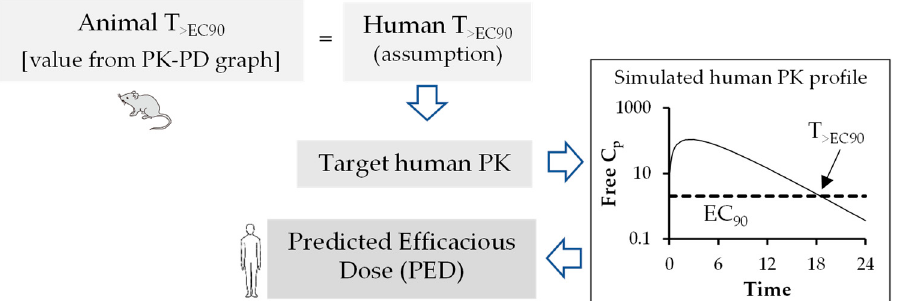
Figure 5. Flow chart for prediction of human e ffi cacious dose using animal T >EC90. Animal T >EC90 value is estimated from PK/PD graph. The human PED is estimated from the simulated free Cp versus time curve with EC 90 level. The dose at which the simulated free Cp versus time curve intersects with the animal T >EC90 value is the human PED.